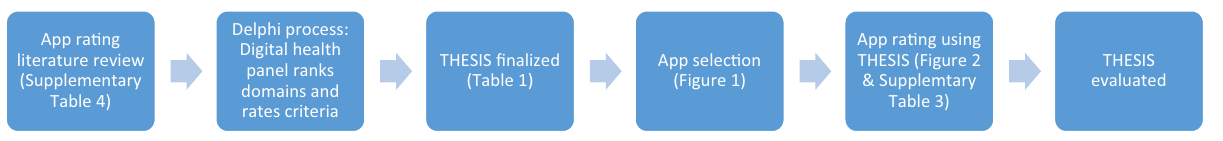
App ra(cid:2)ng using THESIS (Figure 2 & Supplemtary (Figure 1) Table 3)